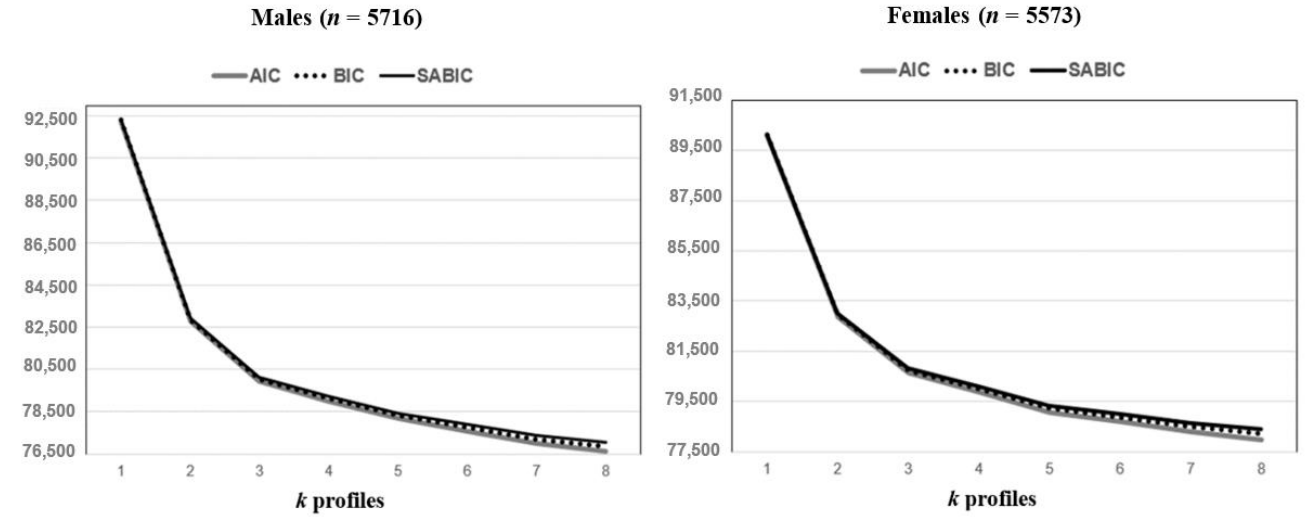
Figure 2. Elbow Plot of the Information Criteria Values.